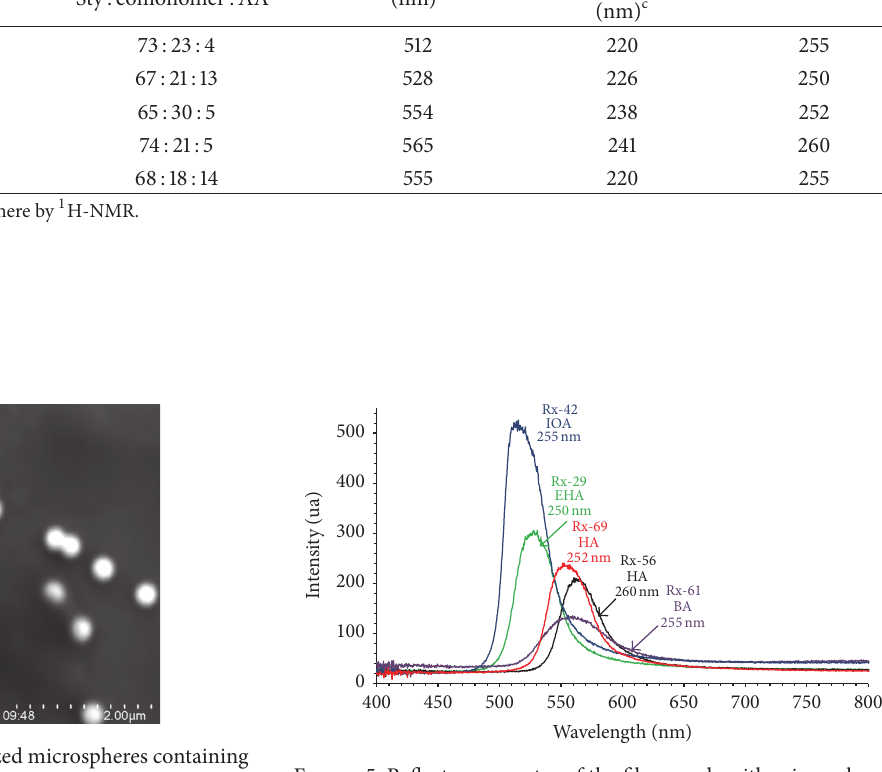
Table 3: Reflection peak position of photonic crystals films, particle diameter predicted by Bragg’s law, and DLS measurements. Sample ID